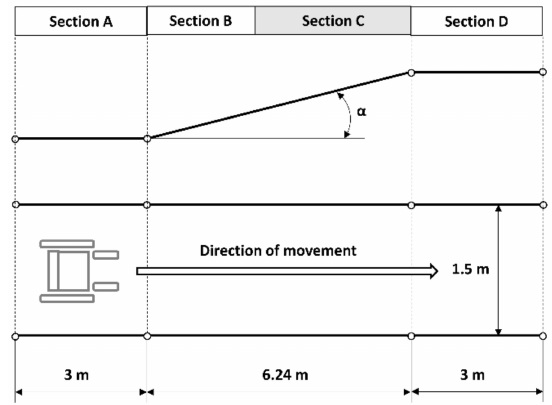
Figure 2. Test ramp outline, where: Section A—a section of the road where the wheelchair was accelerated, Section B—a section of the ramp for which the measurement results were not considered, Section C—a section of the ramp for which measurement was carried out, Section D—a final section in which the wheelchair was stopped, α -ramp inclination